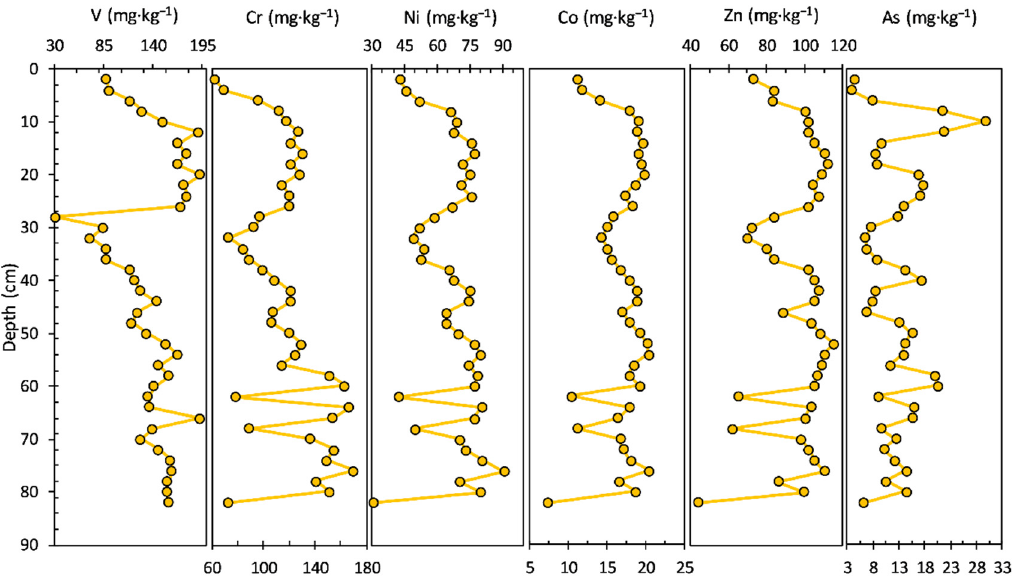
Figure 7. Vertical distribution of geochemical heavy metals (V, Cr, Ni, Co, Zn, As) in the Caineni Lake sediment core (82 cm depth).